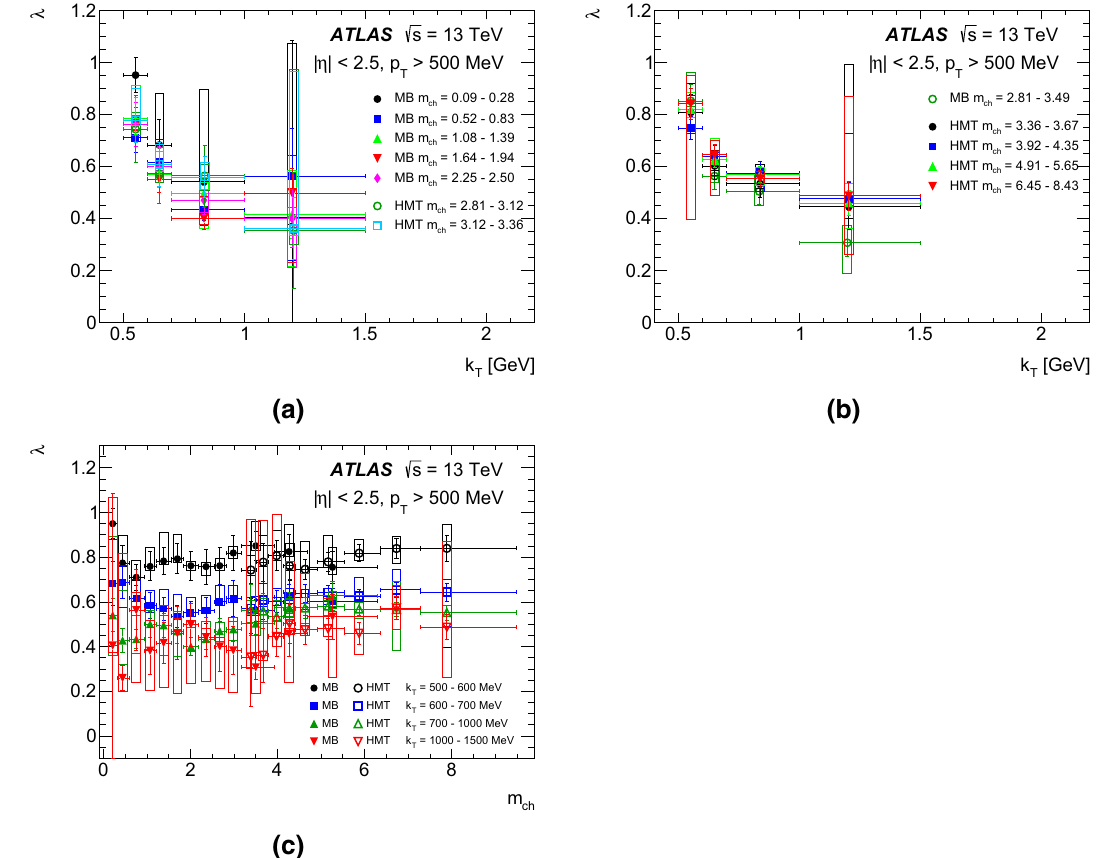
Fig. 13 The parameter λ for p T > 500 MeV: a as a function of k T in selected low m ch intervals, b as a function of k T in selected high m ch intervals, and c as a function of m ch in k T intervals between 0.5 and 1.5 GeV. The error bars and boxes represent the statistical and systematic contributions,